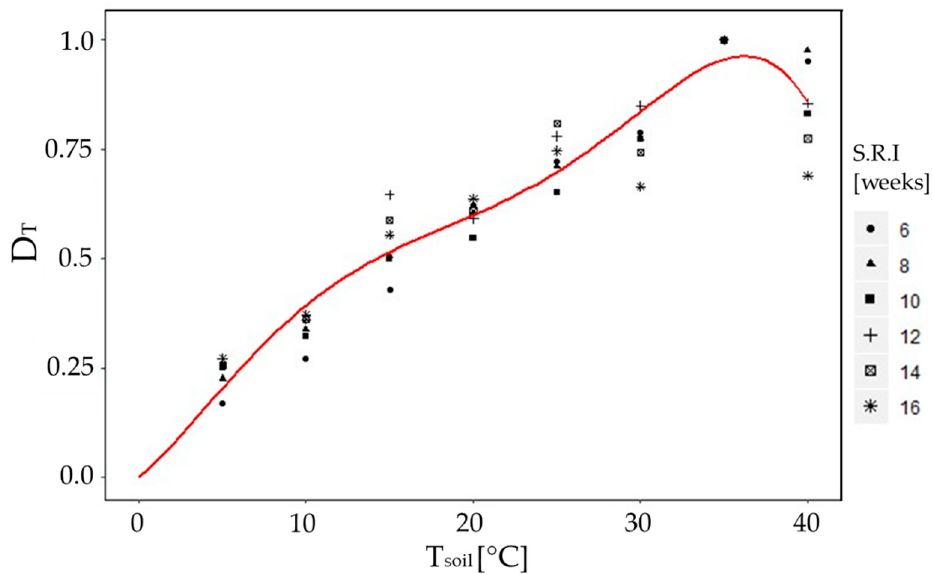
Figure 4. Soil temperature (T soil ) plotted against dose to show the temperature-induced dose com- ponent model for European beech wood exposed to soil contact. The red line is a polynomial function fitted using the OLS optimization procedure. R 2 = 0.9888. S.R.I. = specimen removal interval measured in weeks.